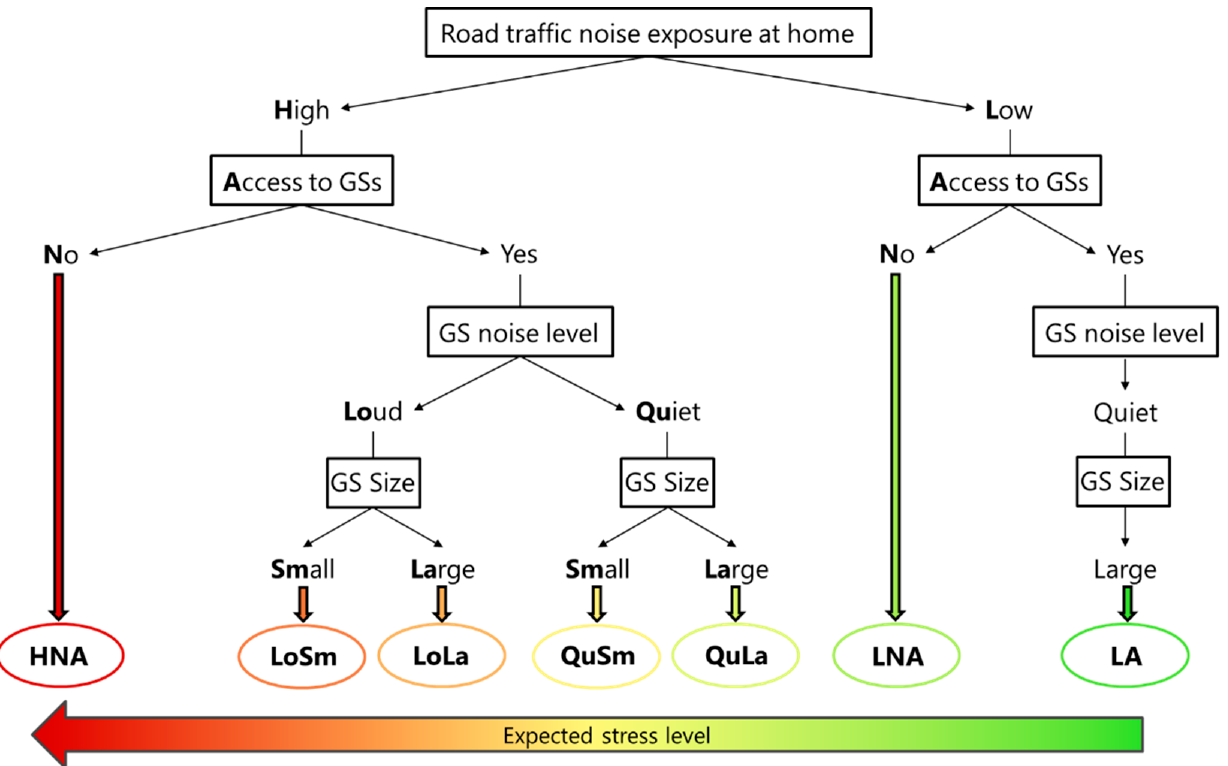
Figure 1. Classification of the seven study groups accounting for road traffic noise exposure at home in combination with access to GSs of varying sizes. The stress level is expected to increase from right to left.